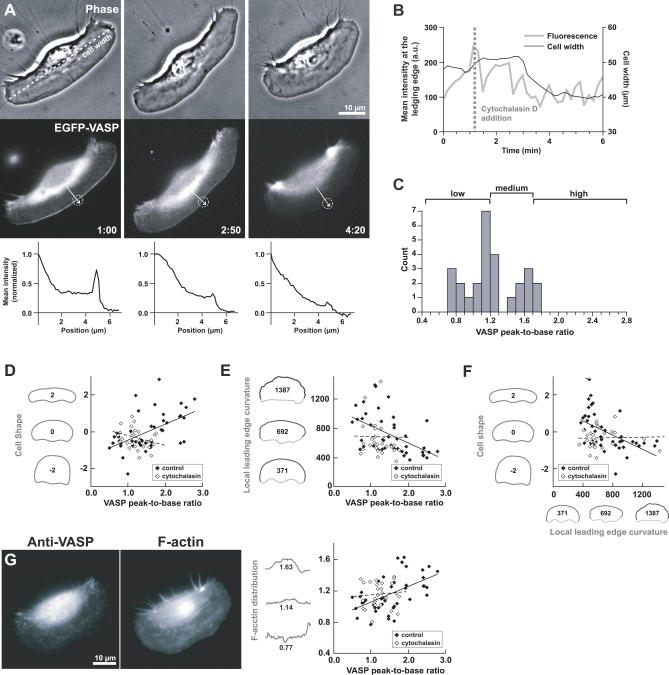
Cytochalasin Delocalizes VASP from the Leading Edge, Changing the F-Actin Network and Cell Shape(A) Time-lapse images show that overexpressed EGFP-VASP, which is enriched at the leading edge before addition of 1.0 μM cytochalasin D (time: 1:00, left panel), becomes weaker at the leading edge ∼2 min after cytochalasin treatment (time: 2:50, middle panel). Cytochalasin D was added at 70 s (∼1.2 min). Approximately 3 min after cytochalasin treatment (time: 4:20, right panel), EGFP-VASP can barely be seen at the leading edge of this keratocyte that begins to exhibit a D shape rather than the original canoe shape. Time = min:s. Scale bar = 10 μm. Fluorescence intensities measured across the leading edge (arrows) quantitatively confirm the enrichment of EGFP-VASP at the leading edge before cytochalasin treatment and its delocalization a few minutes after addition of the drug (bottom graphs).(B) The levels of EGFP-VASP at the leading edge and the width of the keratocyte in (A) were compared as a function of time. Cell width (axis perpendicular to migration) was measured from one side of the cell to the other (dotted line in (A)). EGFP-VASP intensity levels were measured inside a circle (4 μm diameter) placed in the middle of the cell at the leading edge (dotted circles in (A)) in each frame of the time-lapse sequence. These two parameters temporally correlate with each other (r2 = 0.21, p = 0.0009). The levels of EGFP-VASP at the leading edge (thick gray line) dramatically drop ∼2 min after cytochalasin addition (time ∼3 min, dotted line), followed by a decrease in cell width (thin black line).(C) The frequencies of VASP peak-to-base ratios obtained from immunofluorescence images of keratocytes treated with cytochalasin D confirm that VASP becomes displaced from the leading edge. The keratocyte population with high VASP peak-to-base ratios observed in wild-type cells (see Figure 3C) becomes absent after cytochalasin treatment, leaving only cells with low and medium values.(D) Shape mode analysis reveals that cytochalasin treatment (open diamonds) eliminates the population of keratocytes with canoe shapes (>1 in y-axis) compared to control cells (closed diamonds) causing most cells to resemble the mean shape of the population or rounder D shapes. No significant correlation was found between this shape mode and enrichment of VASP at the leading edge (VASP peak-to-base ratio) in cytochalasin treated cells (r2 = 0.09, n = 27, dashed line) compared to control cells.(E) Cytochalasin treatment (open diamonds) eliminates the correlation between local leading-edge curvature and VASP enrichment at the leading edge (r2 = 0.0004, n = 27, dashed line) previously observed in control cells (closed diamonds).(F) The negative correlation between cell shape and local leading edge curvature observed in control cells (closed diamonds) is abolished in cells treated with cytochalasin (open diamonds, r2 = 0.0009, n = 27, dashed line).(G) After cytochalasin treatment, a typical cell has VASP absent from the leading edge (VASP peak-to-base ratio = 0.83) and an F-actin peak ratio of 0.96 corresponding to a flat F-actin distribution along the leading edge. Cytochalasin treatment eliminated cells with peaked F-actin distributions corresponding to high F-actin peak values from our population. In addition, no significant correlation was found between F-actin peak ratios and enrichment of VASP at the leading edge (VASP peak-to-base ratio) in our population of cytochalasin treated cells (r2 = 0.006, n = 27, dashed line) compared to control cells. Scale bar = 10 μm.